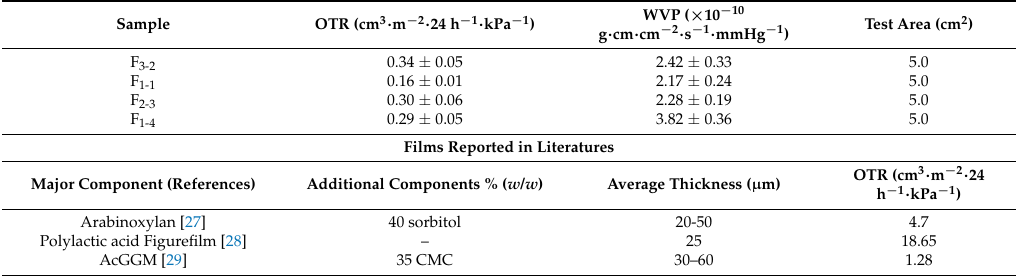
Table 4. Oxygen transfer rate (OTR) and water vapor transmission rate (WVP) of the composite films and the films reported in literatures.